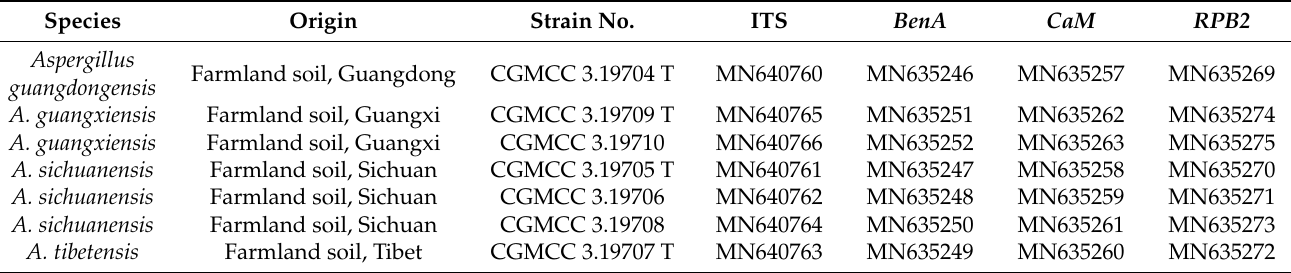
FigTree v1.4.2 (http://tree.bio.ed.ac.uk/software/figtree/, accessed on 1 January 2022) and visualized using Adobe Illustrator CS5. BI posterior probabilities (pp) values and bootstrap (bs) percentages of analysis were labeled at the branch nodes. Values less than 0.95 pp and less than 70% bs were not shown. Branches with values more than 1.00 pp and 95% bs are thickened. Table 1. Strains used in this